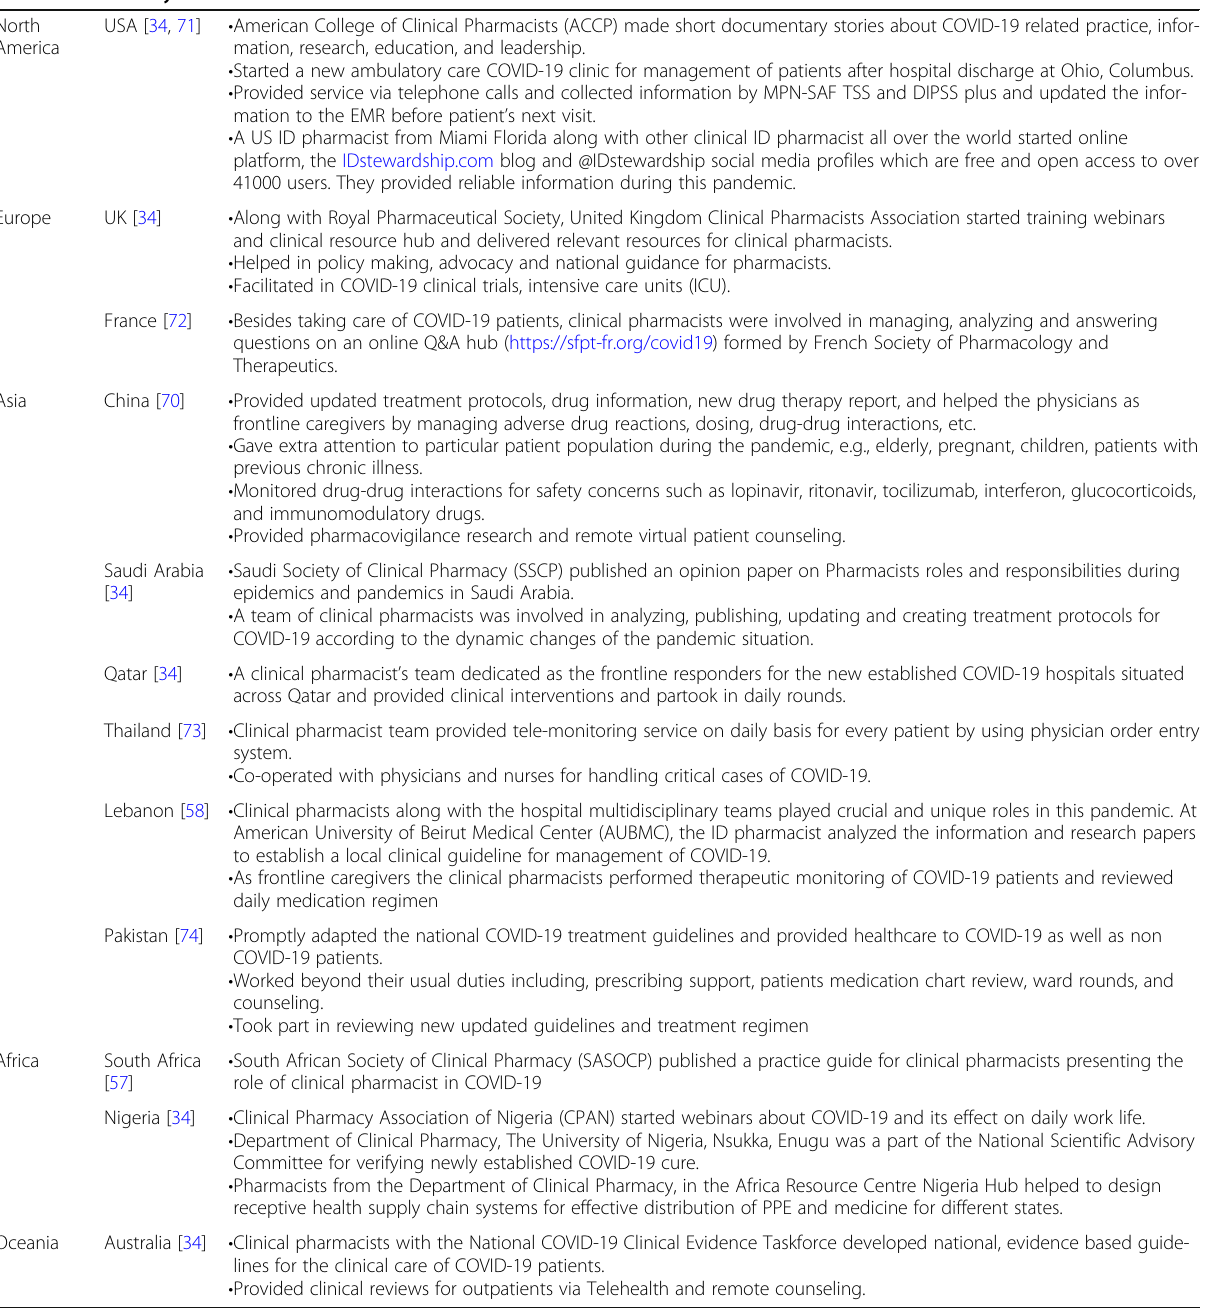
Table 2 Global activities of clinical pharmacists in COVID-19 pandemic Continent